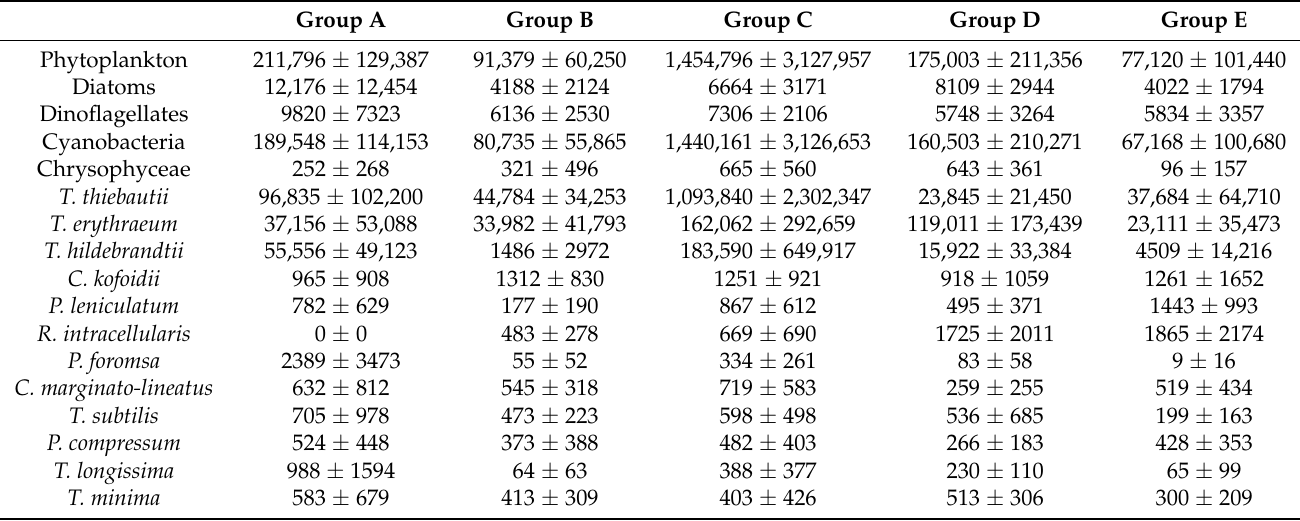
Table 4. List of phytoplankton community group characteristics (average ± standard deviations) identified by cluster analysis in the WPO.